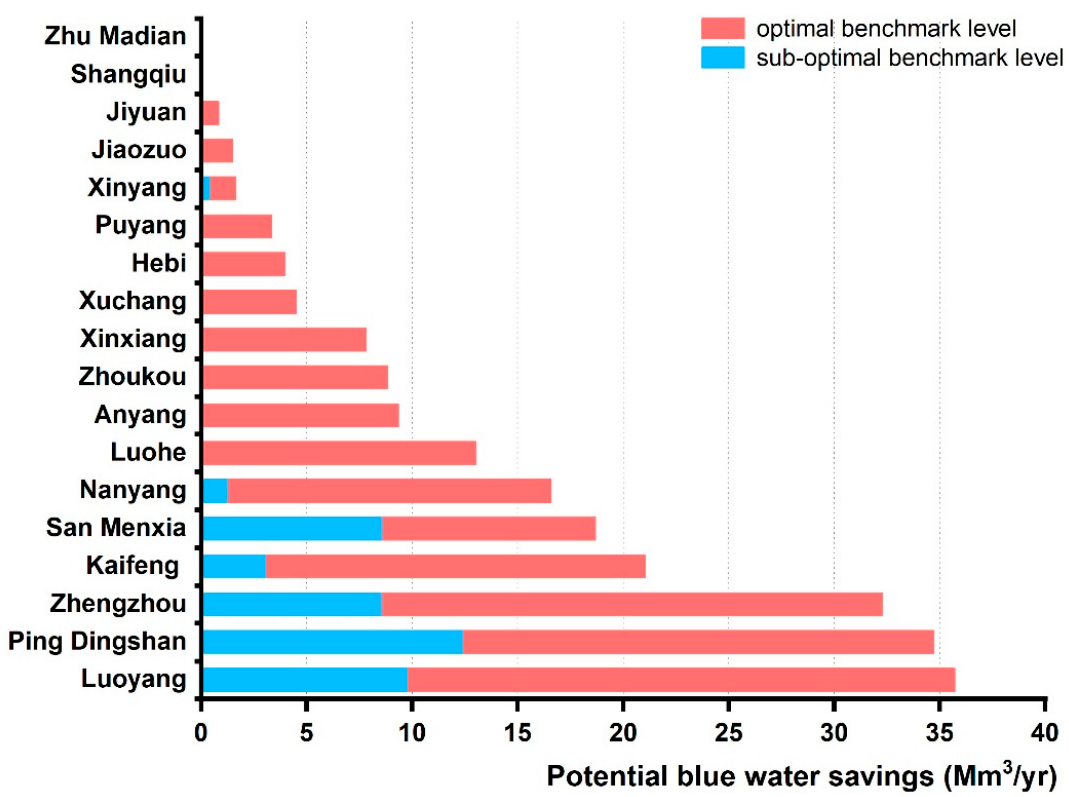
Figure 6. Potential blue water savings of maize production at optimal or sub-optimal benchmark levels in 18 cities.